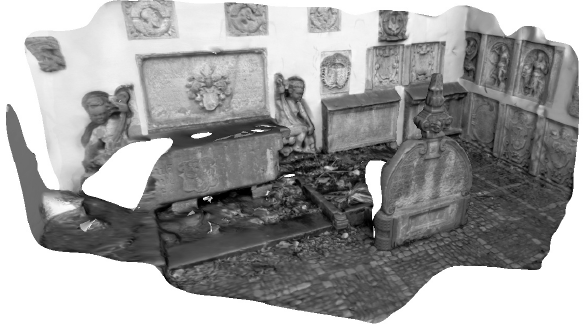
Figure 1: Part of Mindener Museum's lapidarium - textured mesh from Autodesk